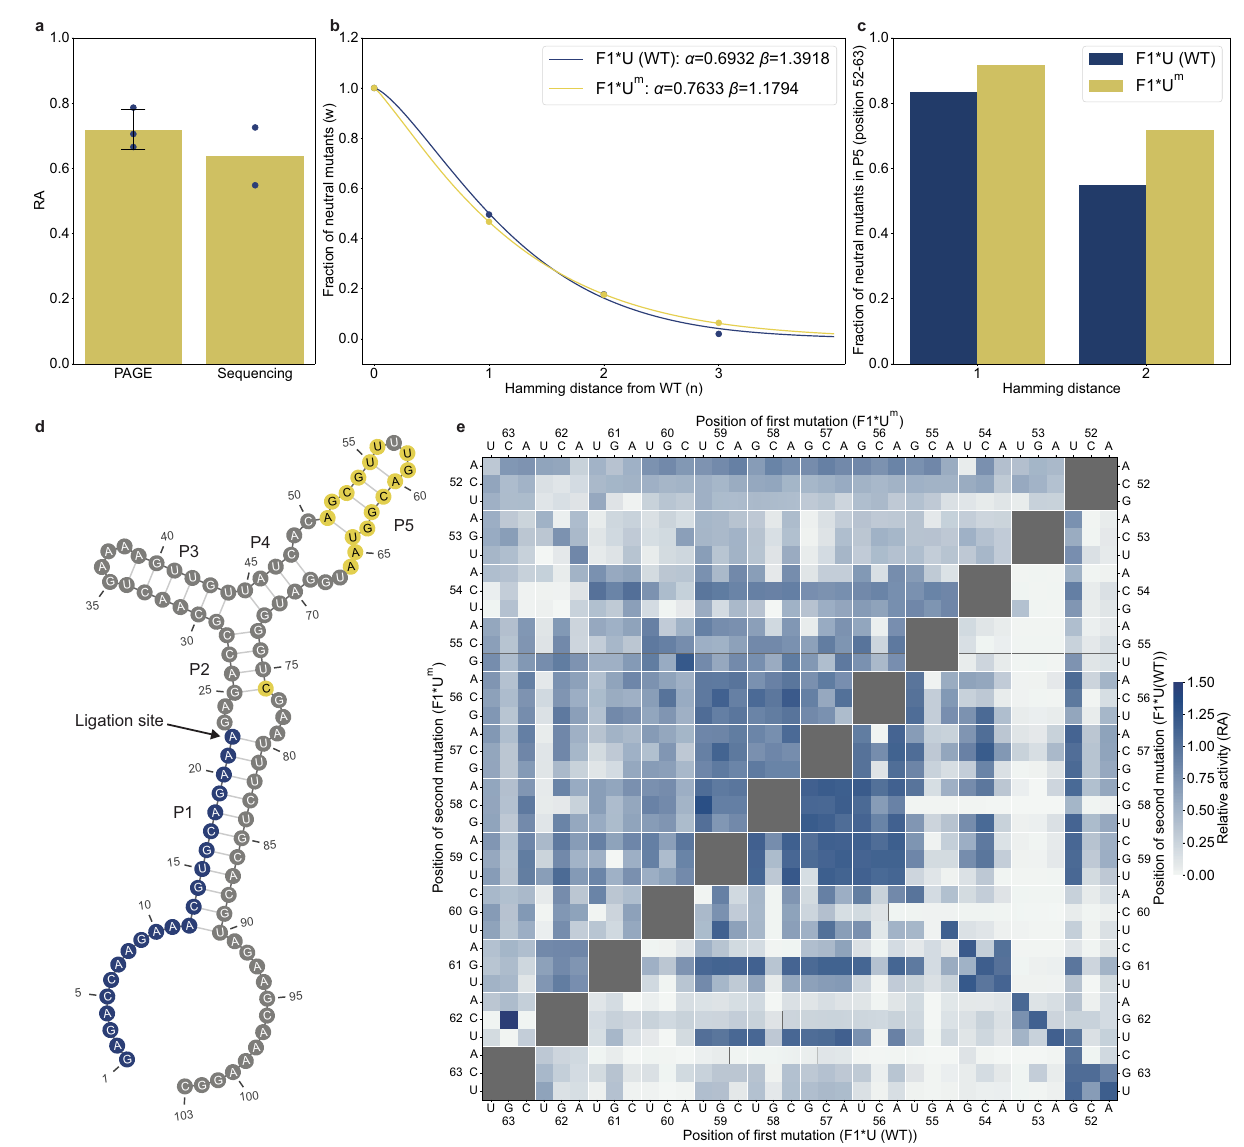
Fig. 4 | F1*U m has a more mutationally robust P5 stem than F1*U. a Comparison between RA values of F1*U m determined by PAGE and sequencing. PAGE experi- ments were performed in triplicate, and sequencing experiments were performed in duplicate. Data are presented as mean value for sequencing experiments and mean value +/ − SD for PAGE experiments. b The decline in the fraction of neutral mutants ( ω ) due to mutation accumulation ( n ) fi tted to the directional epistasis model ω n ð Þ = e (cid:2) α n β by the nonlinear least square method (SciPy, Python). α is the decay parameter where lower α indicates higher mutational robustness. β is